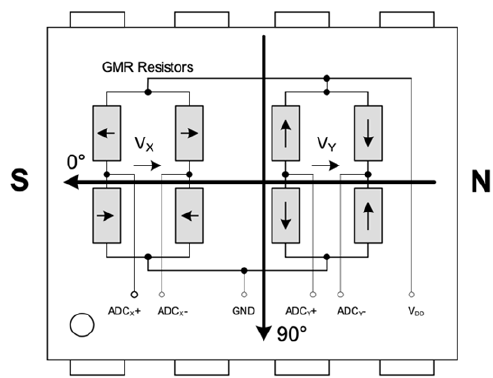
Figure 11. Exemplary GMR sensor die in a magnetic field (i.e., north pole (N) and south pole (S)) containing the sensitive GMR bridges, where V x and V y are the sinusoidal output voltages for further angle determination accessible via differential ADC outputs (i.e., ADC x+ , ADC x− , ADC y+ , ADC y− ), reproduced from [34]. Copyright 2020, Infineon Technologies AG.